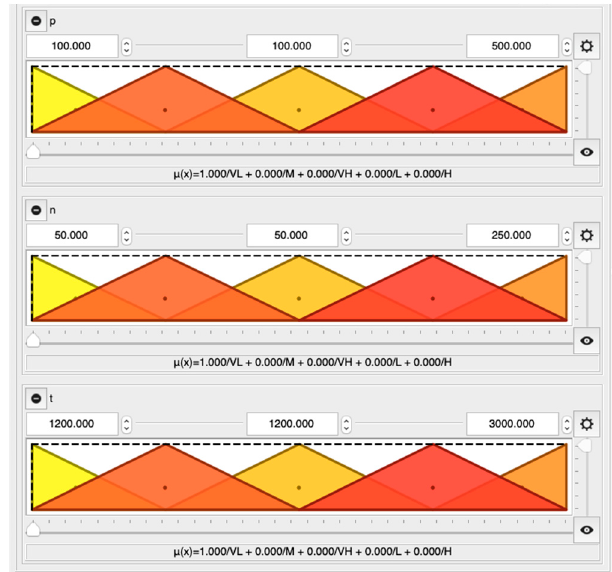
Figure 4. Membership functions for input parameters: p, n, t (x-axes and y-axes correspond to parameter values from Table 2 and values of membership function, respectively).